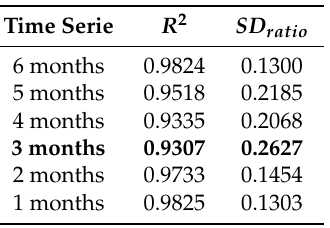
Table 7. Performance Indices for validation with the worst performance highlighted.